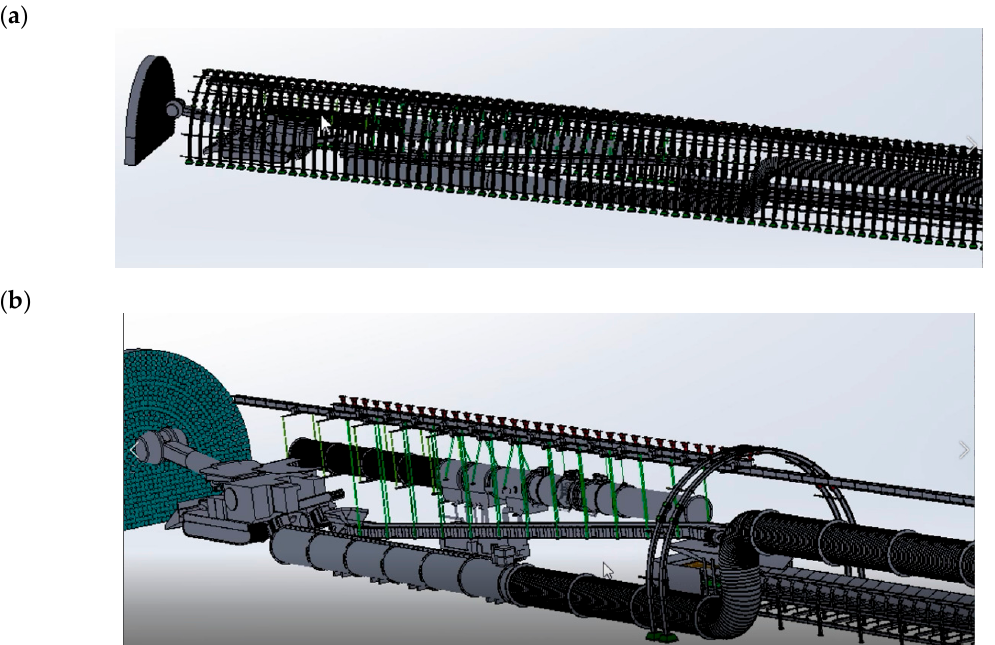
Figure 3. The arrangement of excavation devices in the geometrical model (5-m overlap zone), ( a ) full view, ( b ) view without arch